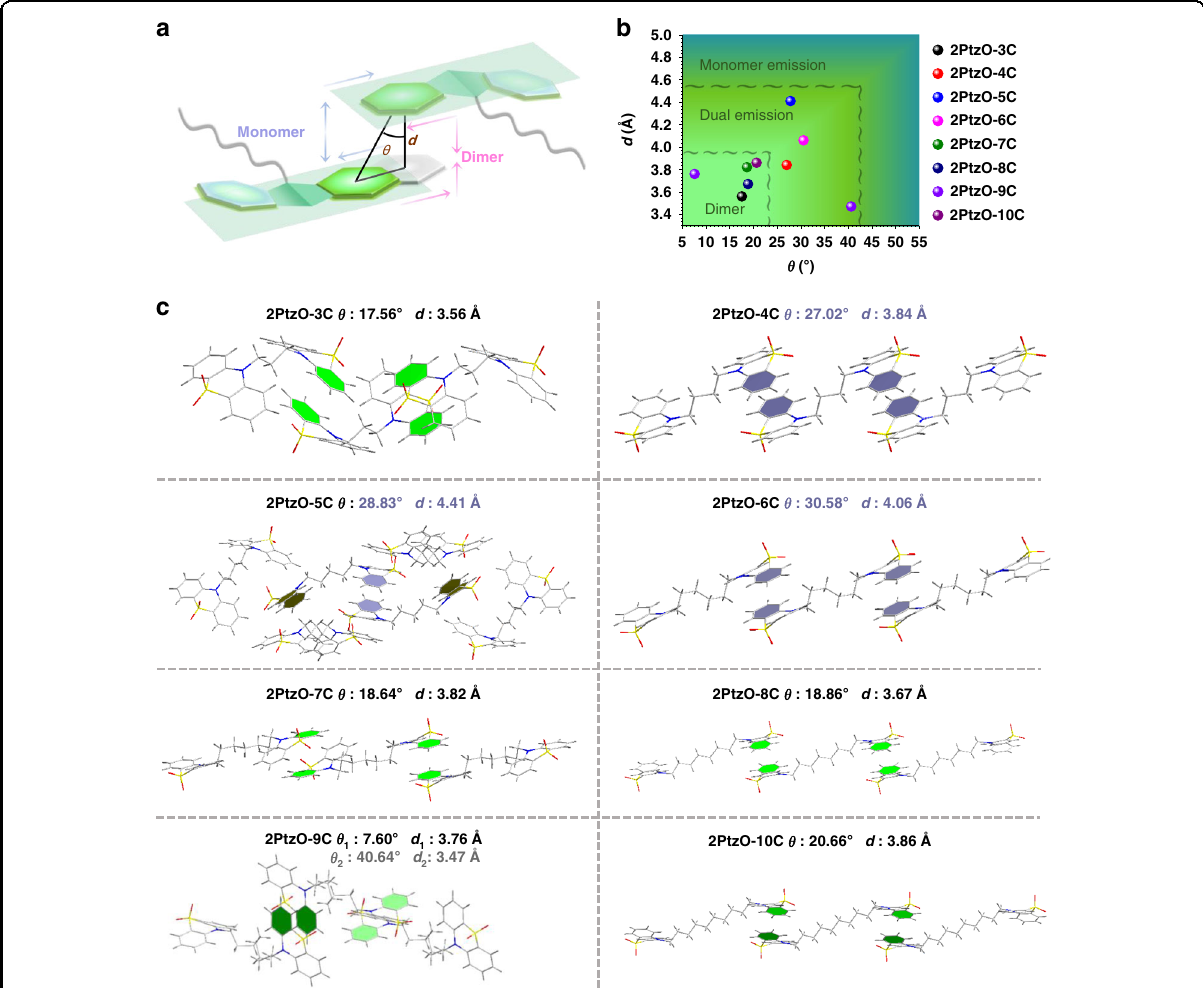
Fig. 3 X-ray single crystal diffraction data of 2PtzO-nC crystals. a Cartoon graph of π - π stacking: the movements of magenta arrows represent stronger π - π interaction and blue arrows represent weaker π - π interaction ( d : vertical distance between the adjacent benzene planes. θ : displacement angle, the angle between the centroid – centroid line and the vertical line). b The scatter diagram based on the vertical distance ( d ), displacement angle ( θ ) and RTP behavior of 2PtzO-nC crystals. c Single-crystal structures of the eight target compounds. Phenyl rings involved in the stronger π - π interactions are labeled by green color, weaker π - π interactions by indigo blue color and none π – π interactions by dark yellow